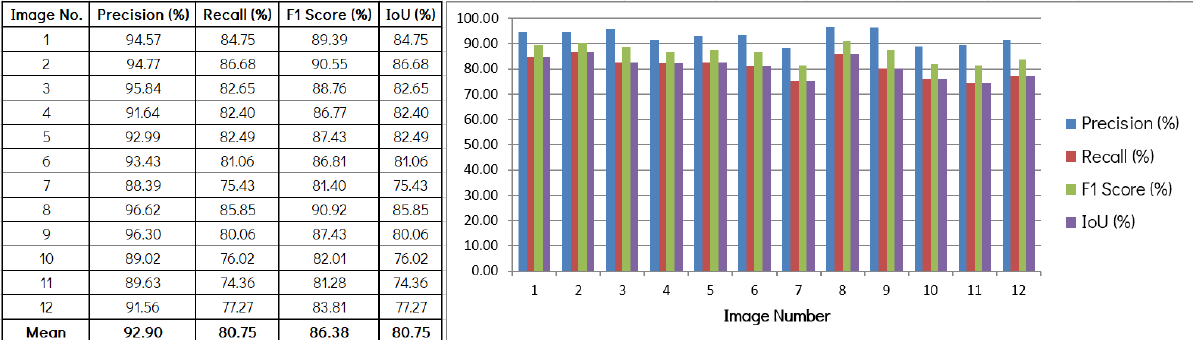
Figure 3. Results of the AI-aided 2D semantic segmentation for the “Buildings” class on the input close range images showing four metrics (precision, recall, F1 score, and IoU) commonly employed in pattern recognition.